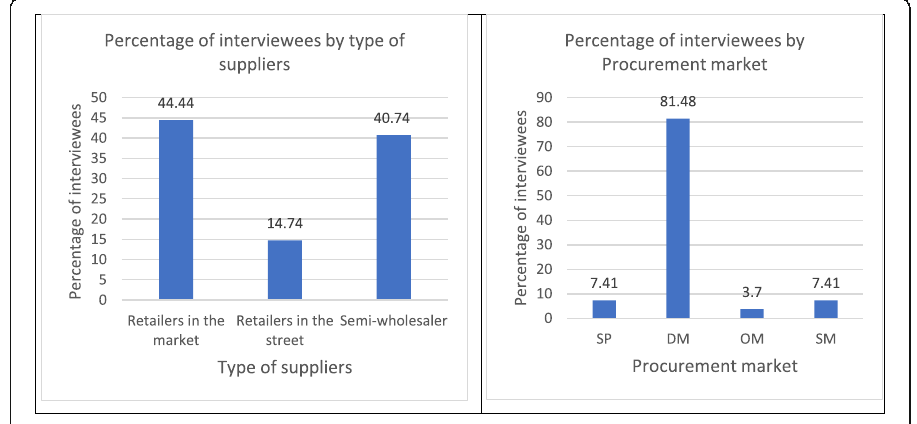
Fig. 3 Type of cowpea providers and supply markets. Source: Survey results, November to December